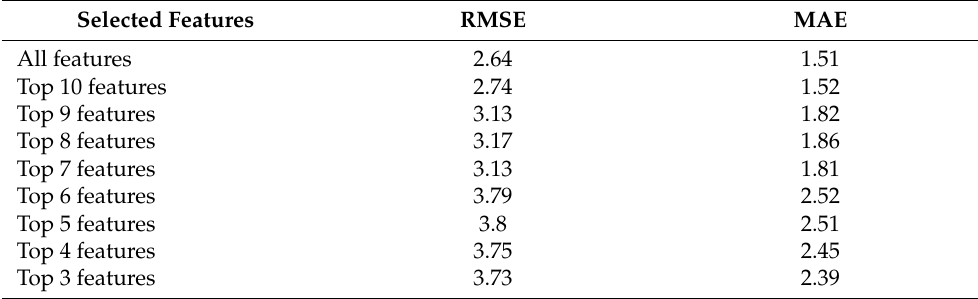
Table 2. Performance RMSE and MAE statistic results of the H 2 model.